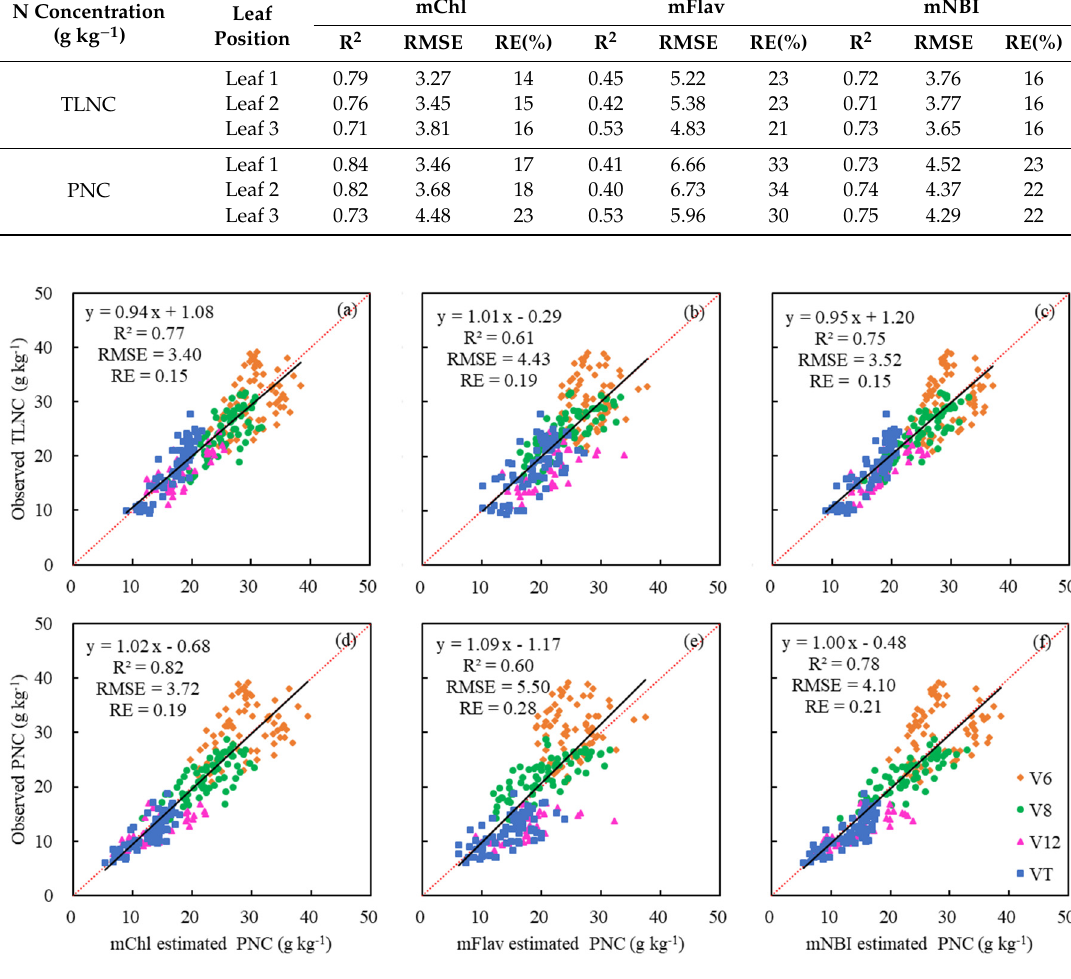
Figure 8. Validation results for the prediction of TLNC ( a – c ) and PNC ( d – f ) using the mean values of modified Dualex 4 parameters for three single-position leaves. Black and red lines indicate the regression and the 1:1 line, respectively.